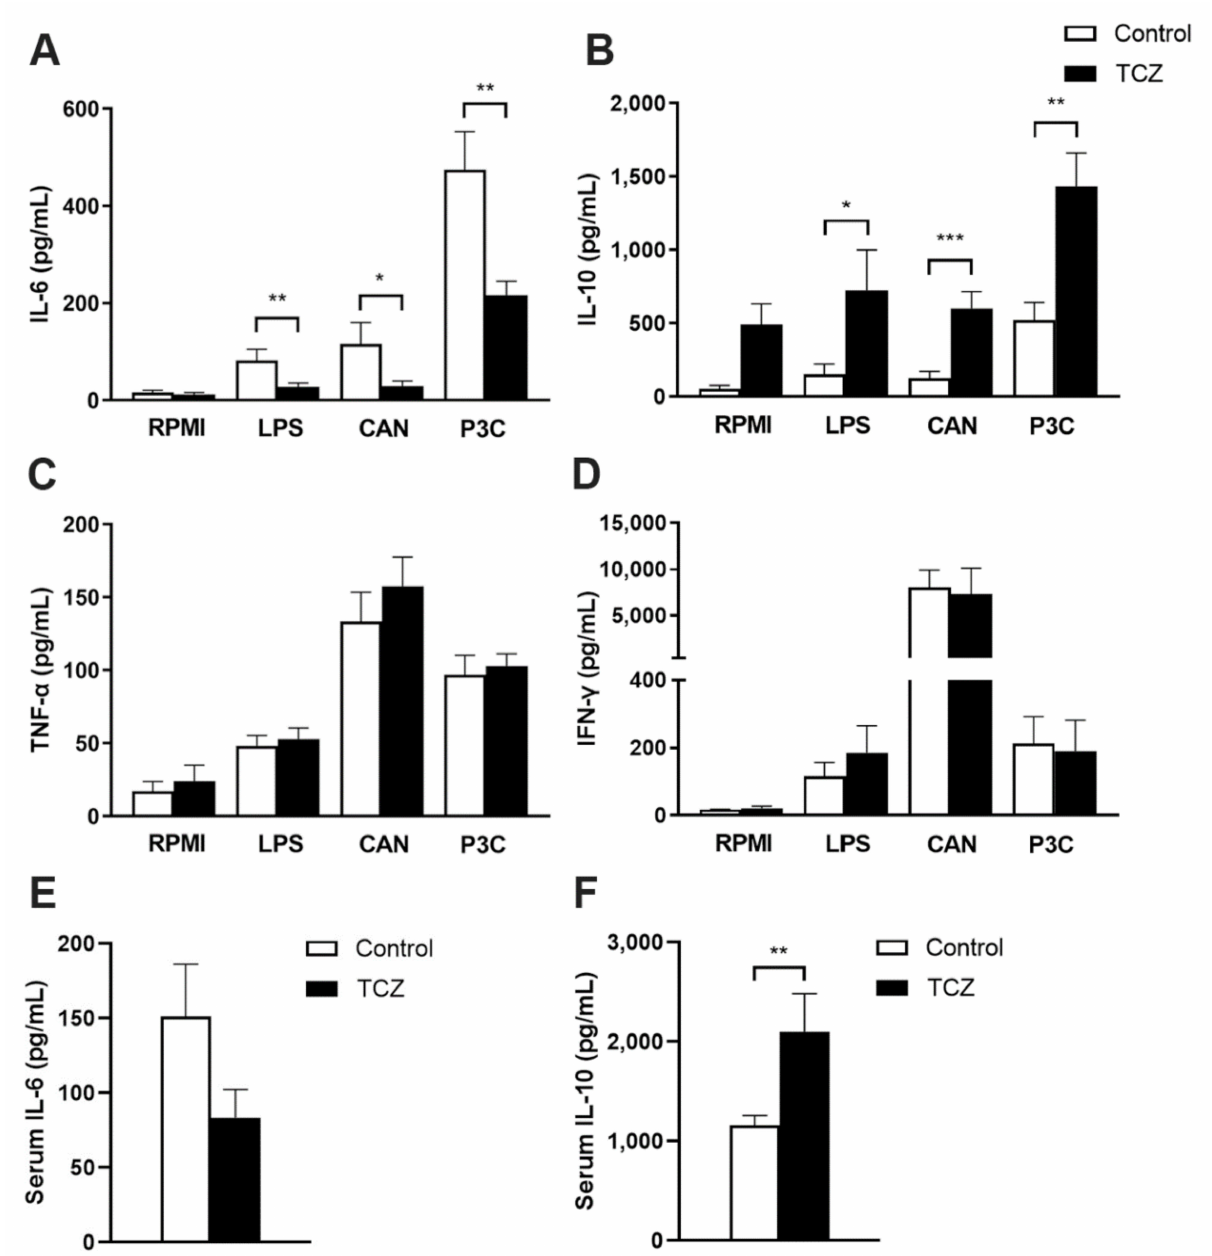
Figure 3. Mice were infected with C. albicans on D0 followed by the treatment with either saline or tocilizumab (TCZ) on D2 and D4, and the study was terminated on D5. The spleens were obtained and crushed, and the splenocytes were stimulated with RPMI, LPS, CAN, and P3C. Supernatants from splenocyte stimulation were isolated and ( A ) IL-6, ( B ) IL-10, ( C ) TNF- α , and ( D ) IFN- γ levels were quantified by ELISA and n = 20, pooled from five experiments (mean ± SEM). ( E ) Serum IL-6 and ( F ) serum IL-10 quantified by ELISA in the control vs. TCZ-treated mice and n = 10, pooled from two experiments (Mean ± SEM). * p < 0.05, ** p < 0.01, *** p < 0.001 for splenocytes or sera cytokines from the control vs. TCZ-treated mice using Mann–Whitney U